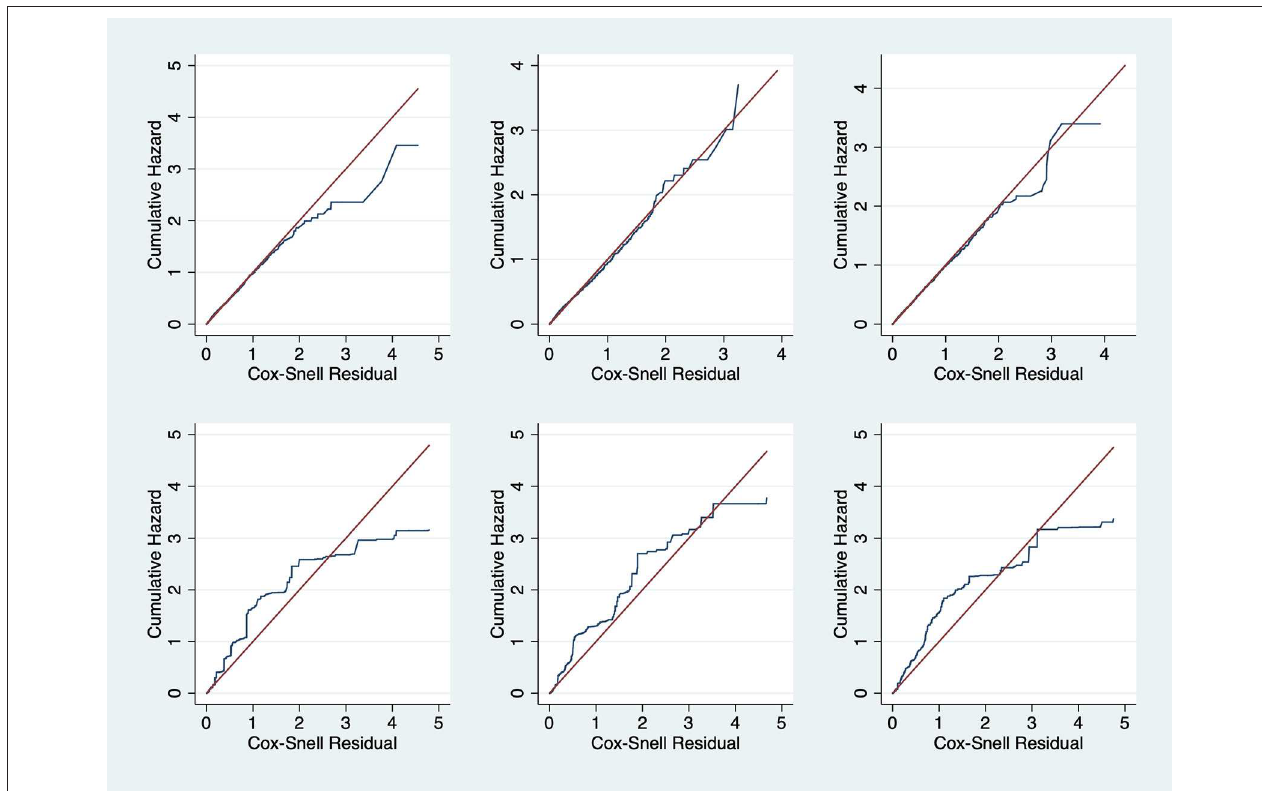
FIGURE 4 | Cox-Snell residual against cumulative hazard goodness-of-fit tests for the Zimbabwe DHS 2005–06 (left column), 2010–11 (middle column) and 2015 (right column). Model 1 (top row) and Model 2 (bottom row).